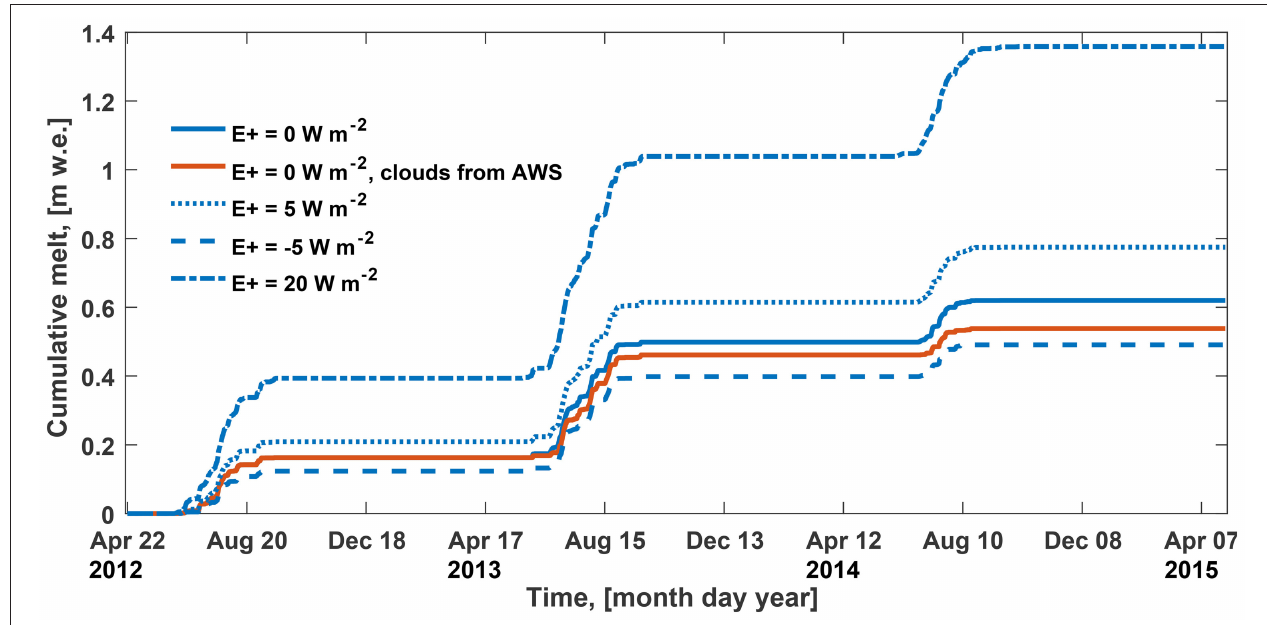
FIGURE 7 | Simulated cumulative melt rate at the Lomonosovfonna ice field in April 2012–2015 for different forcings and settings of the energy balance scheme. Blue lines are used when cloud forcing is provided by WRF, red - cloud forcing is approximated following Kuipers Munneke et al. (2011) using AWS measurements of LW and air temperature, when those are available, when not WRF output is ↓